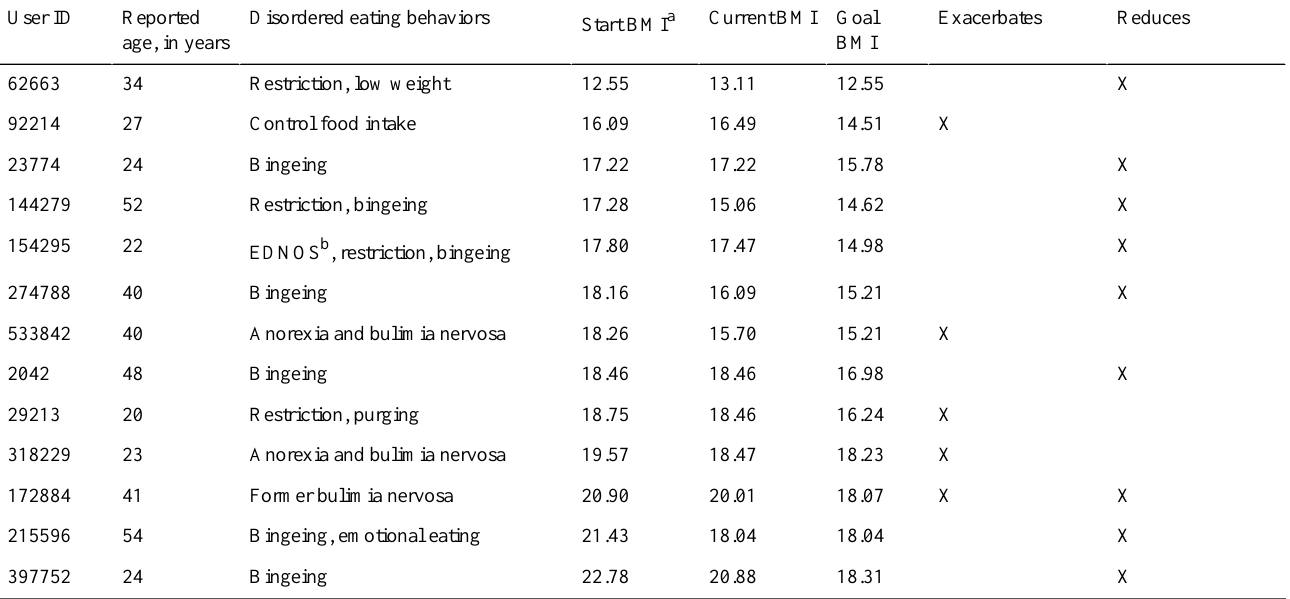
Table 1. Users’age, body mass index (BMI), symptoms, and app